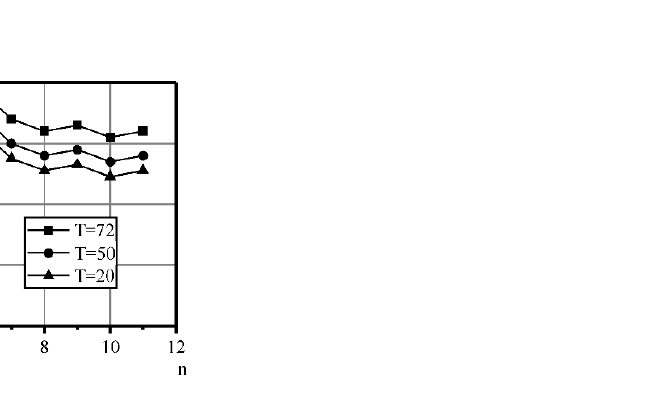
Figure 2. Milk homogenization coefficient versus the number of processing cycles at different temperature values curve (cavitation coefficient λ = 2.5): 1—20 °C, 2—50 °C, 3—72 °C.